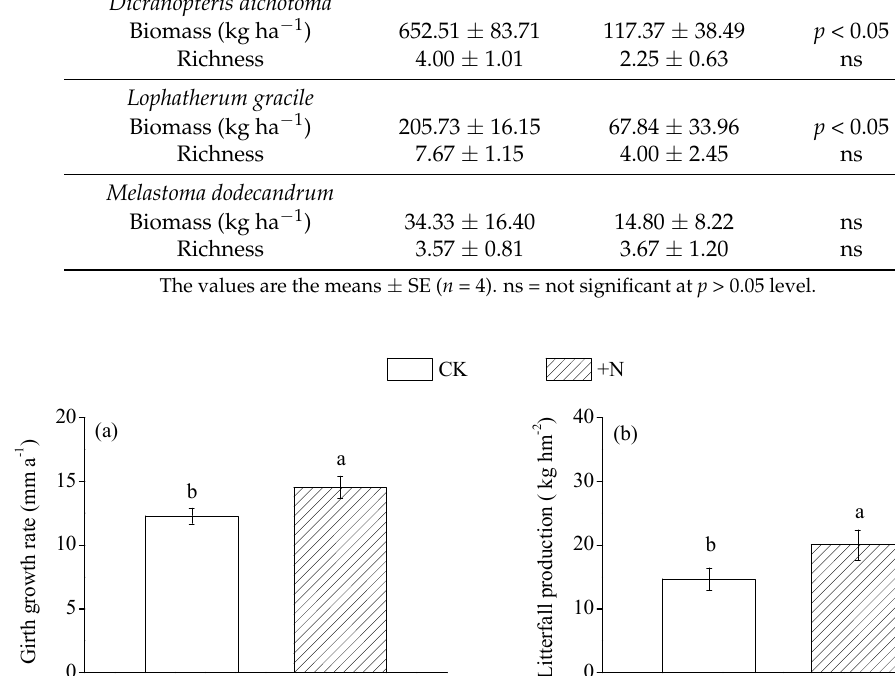
Figure 1. Girth growth from 2011 to 2015 ( a ) and litterfall production in 2016 ( b ) of the Chinese fir tree plantation treated by nitrogen addition (+N) or in the control (CK). Note: Values shown are the means ± SE ( n = 4). Lowercase letters indicate significant differences at the p < 0.05 level between the control and N-treatment plots.